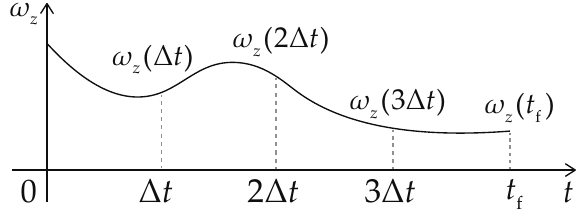
Figure 10. The spline profile of the angular